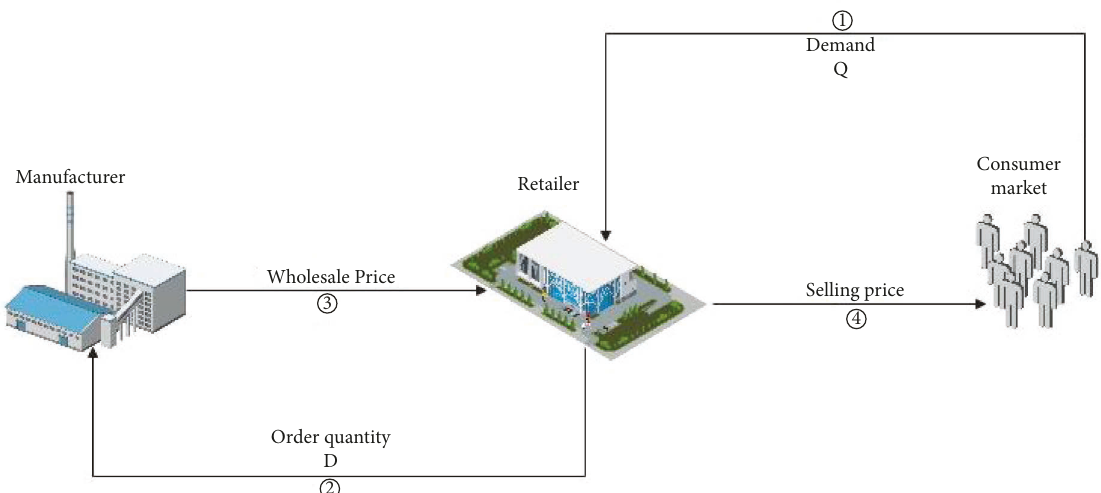
Figure 1: Model decision process.